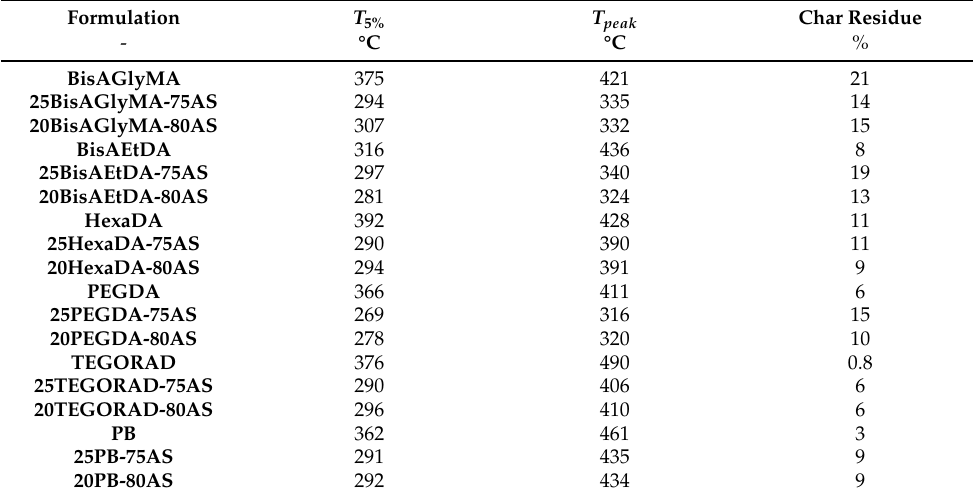
Table 4. Thermal properties of the composites (inert).